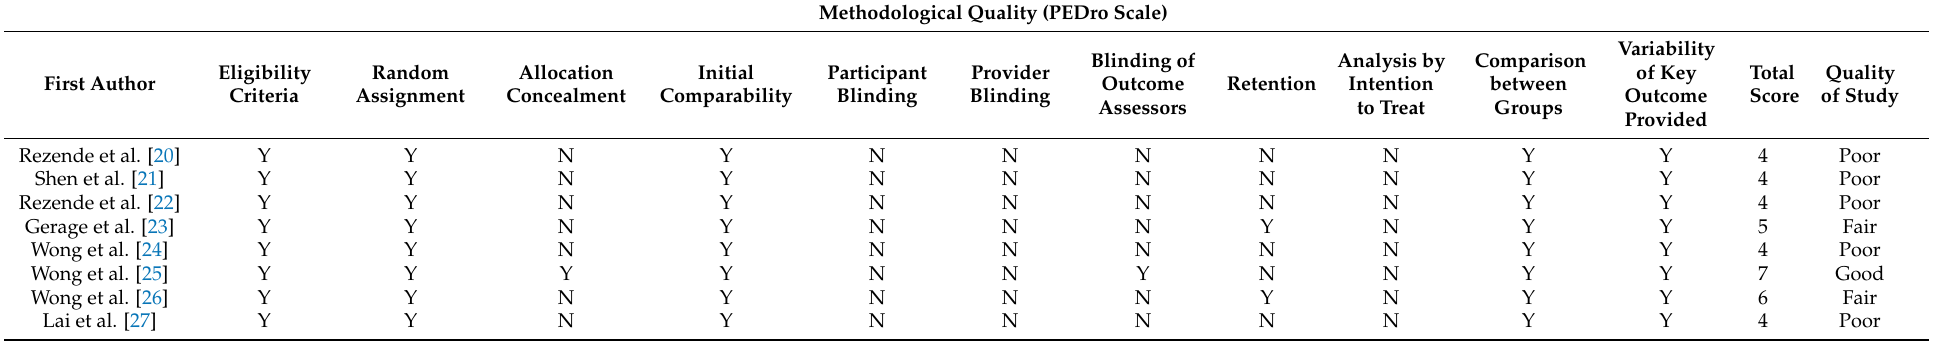
Table 1. Methodological quality for the included trials.